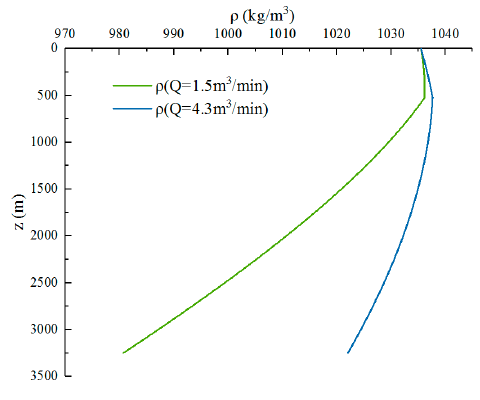
Figure 9. Density profile in the wellbore.